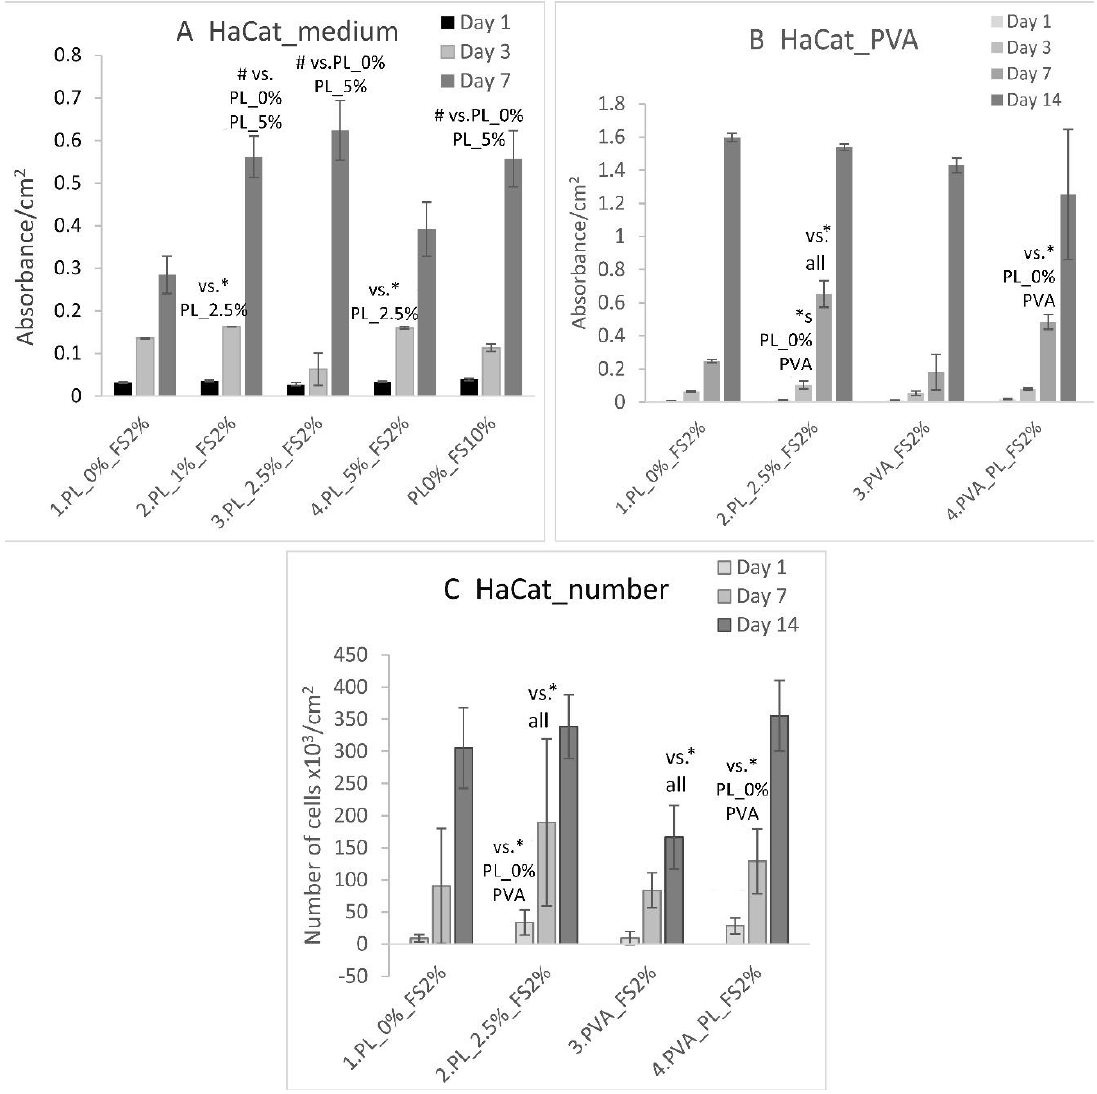
Figure 4. Viability of the HaCaT cells cultured on glass in Dulbecco’s modified Eagle medium (DMEM) supplemented with 2% fetal bovine serum (FS) and 0, 1, 2.5 and 5% of PL, and in DMEM supplemented with 10% of FS ( A ). The viability ( B ) and population density ( C ) of the HaCaT cells in DMEM supplemented with 2% of FS and 0 and 2.5% of PL, and in DMEM supplemented with 2% of FS and with the addition of PVA and PVA–PL nanomats. The cells were cultured for 1–7 days ( A ) and for 1–14 days ( B , C ). The data are presented as the mean ± S.D., # is used for p < 0.001, * for p < 0.05.